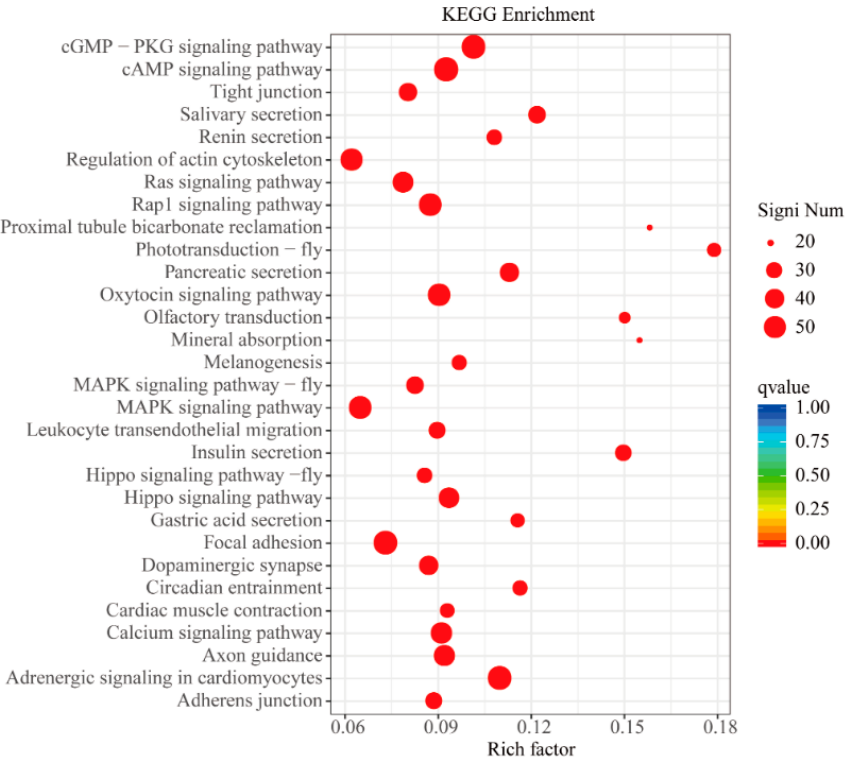
Figure 6. KEGG enrichment scatterplots of differentially expressed genes (DEGs) in FW leeches and SW leeches.